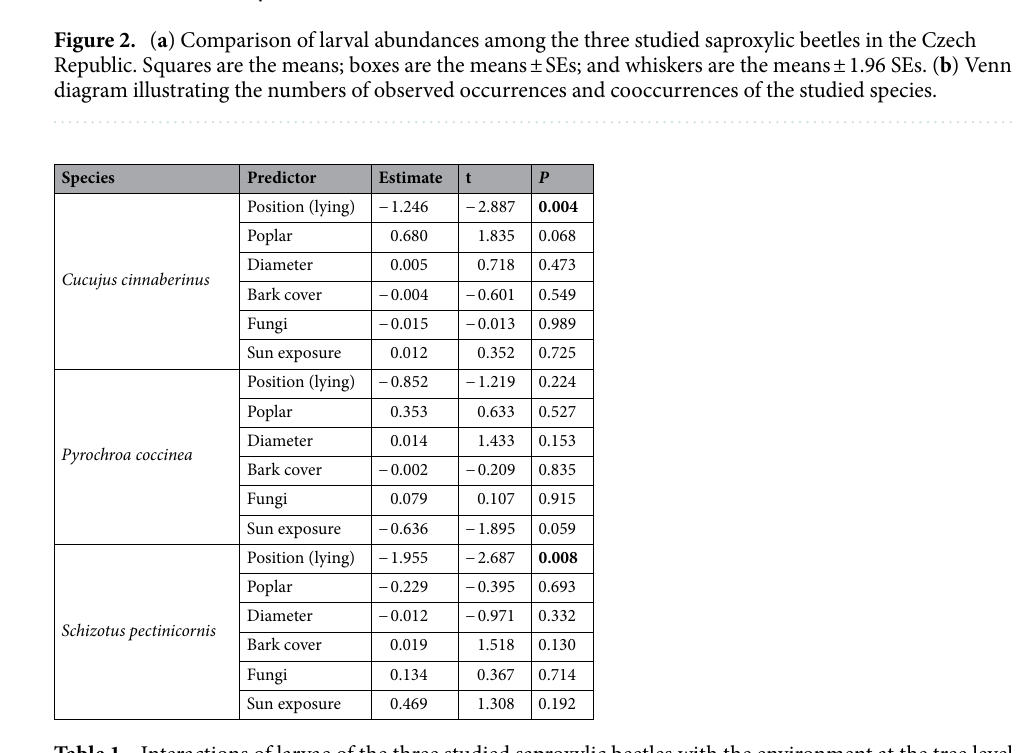
Table 1. Interactions of larvae of the three studied saproxylic beetles with the environment at the tree level in the Pardubice Region (Czech Republic). GLM was used and significant P values are shown in bold.